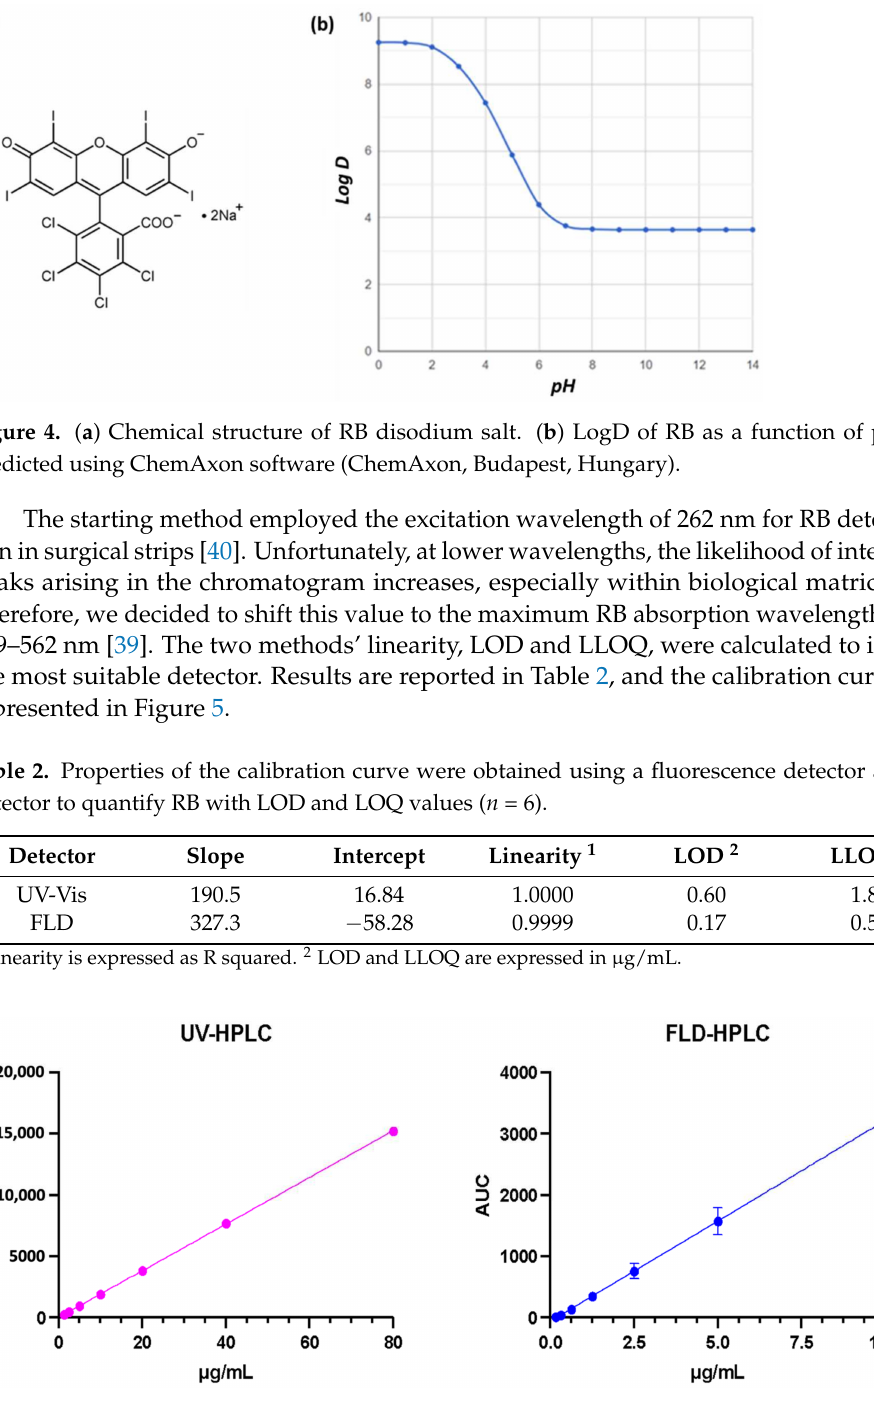
Figure 5. Calibration curves of RB obtained with UV-HPLC and FLD-HPLC detection (means ± SD, n =